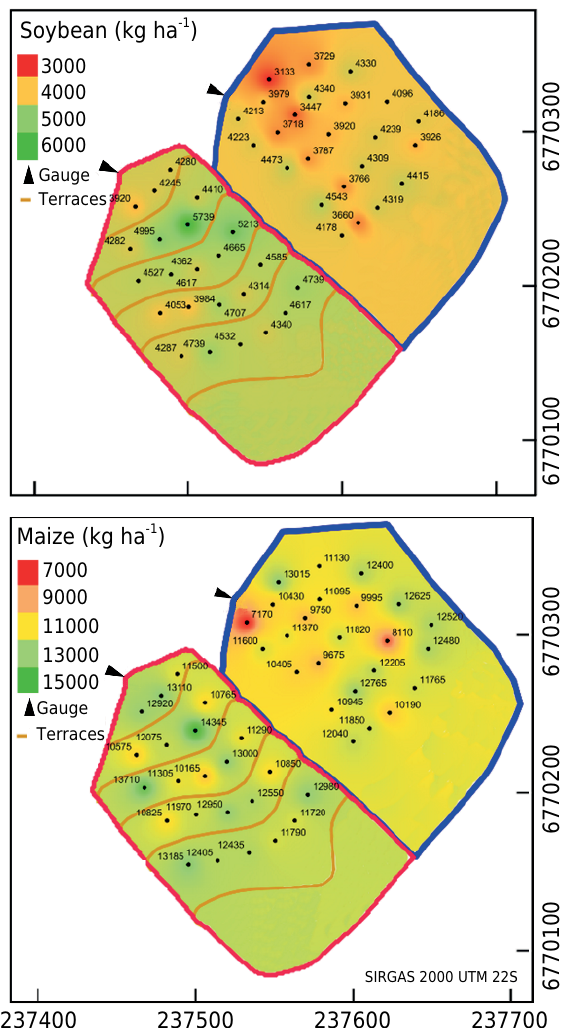
Figure 6. Yield map of soybean and corn in the non-terraced catchment (NTC) and terraced catchment (TC) in Rio Grande do Sul State, southern